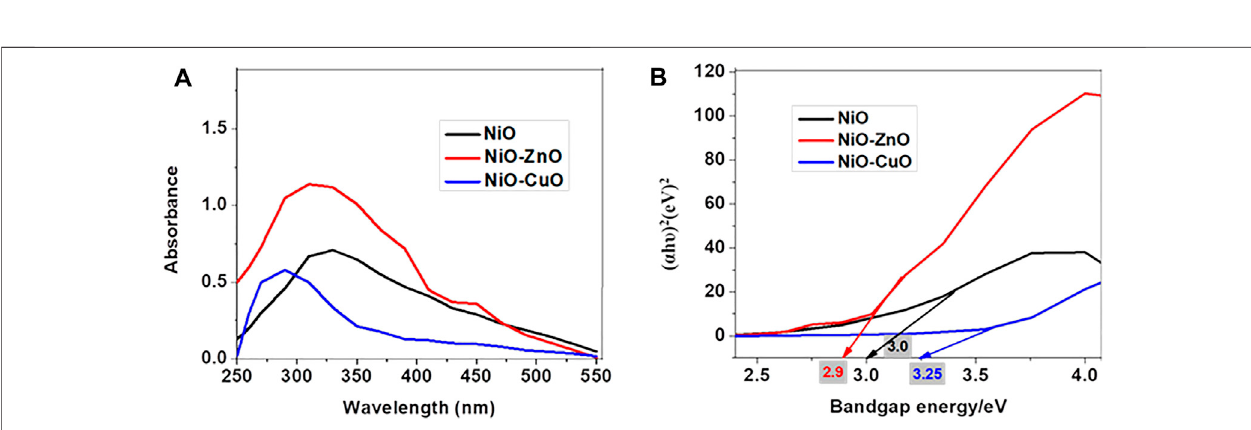
Frontiers in Materials |